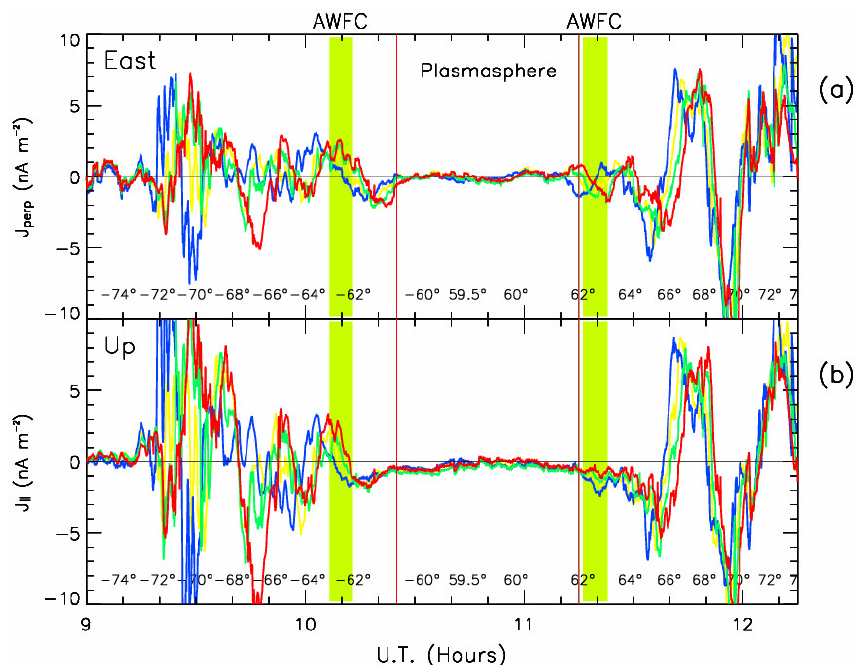
Fig. 5. Rough estimates of FAC densities obtained by applying Ampere’s law to FGM magnetic field perturbations shown in Fig. 4. The results do not allow for the oblique geometry of the orbits and are shown for all four satellites: Cluster 1 (blue), Cluster 2 (green), Cluster 3 (yellow), and Cluster 4 (red). (a) The azimuthal current estimated using J ⊥ = 1B x / ds , and (b) the FAC estimated using J || = 1B y / ds where s is spatial distance along the satellite trajectory. These results have been smoothed on a scale of ∼ 2000km in an attempt to recover the large-scale features.